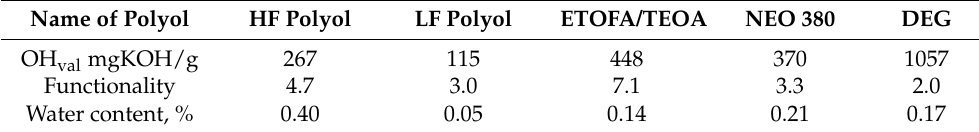
Table 1. Characteristic of different polyols used for rigid PUR foam